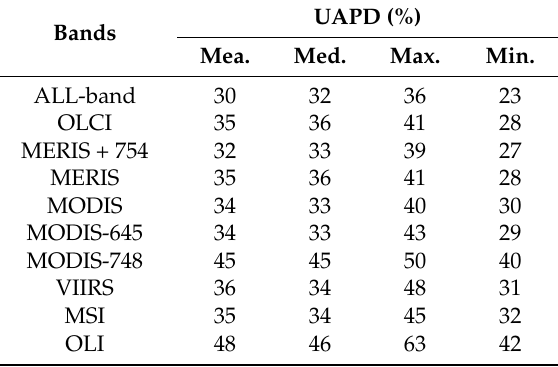
Table 5. The mean (Mea.), median (Med.), maximum (Max.), and minimum (Min.) of unbiased absolute percentage differences (UAPD, %) of a Gau ( λ ) estimated from R rs ( λ ) with the spectral bands of different sensors for the MS, LT and LE datasets. MERIS+745: MERIS with the 745 nm band; MODIS-645/748: MODIS bands without 645 or 748 nm band. UAPD (%) Bands Mea.